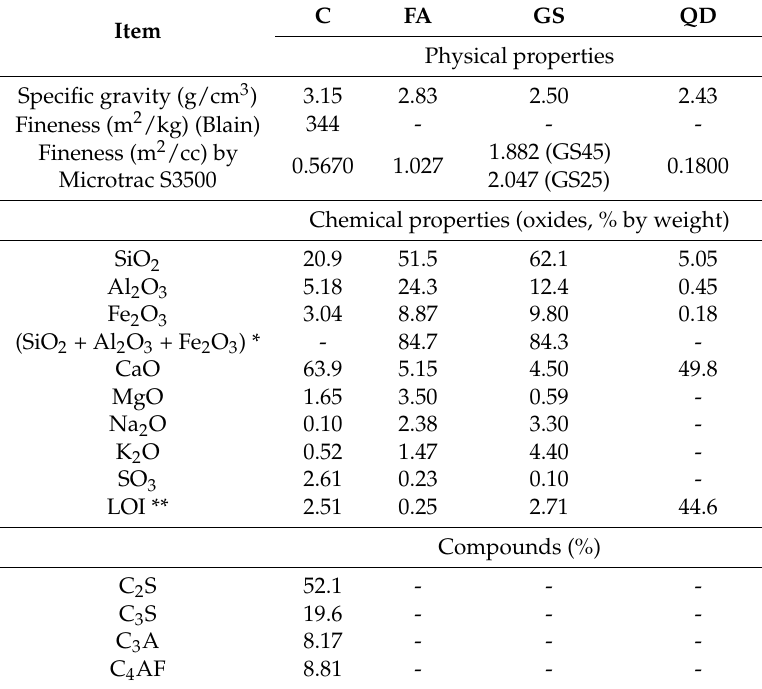
Table 2. Physical and chemical analyses of materials. FA, fly ash; GS, granite sludge; QD, quarry dust.